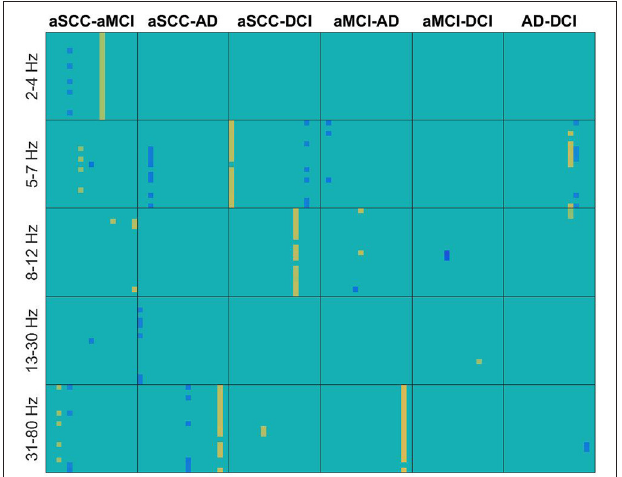
FIGURE 3 | Heatmaps of the t -values of group differences of all electrode × electrode interactions for real valued coherence, sorted by groups comparisons in columns and frequency ranges in rows. Colors indicate values from − 4.11 (dark blue) over zero (green) to + 5.24 (yellow). All values that were not included for classification were set to zero. If the first group of the group comparison (e.g., aSCC in aSCC-aMCI) has higher values than the second group, this results in a positive t -value, i.e., yellow colors. Electrodes start from top to bottom and from left to right following the order: F3, F4, C3, C4, P3, P4, O1, O2, F7, F8, T3, T4, T5, T6, Fz, Cz, and Pz. AD, Alzheimer’s disease; DCI, depression with cognitive impairment; aMCI, mild cognitive impairment